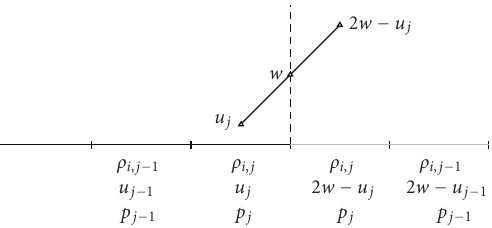
Figure 4: Moving wall boundary conditions for Euler equations in one space dimension.